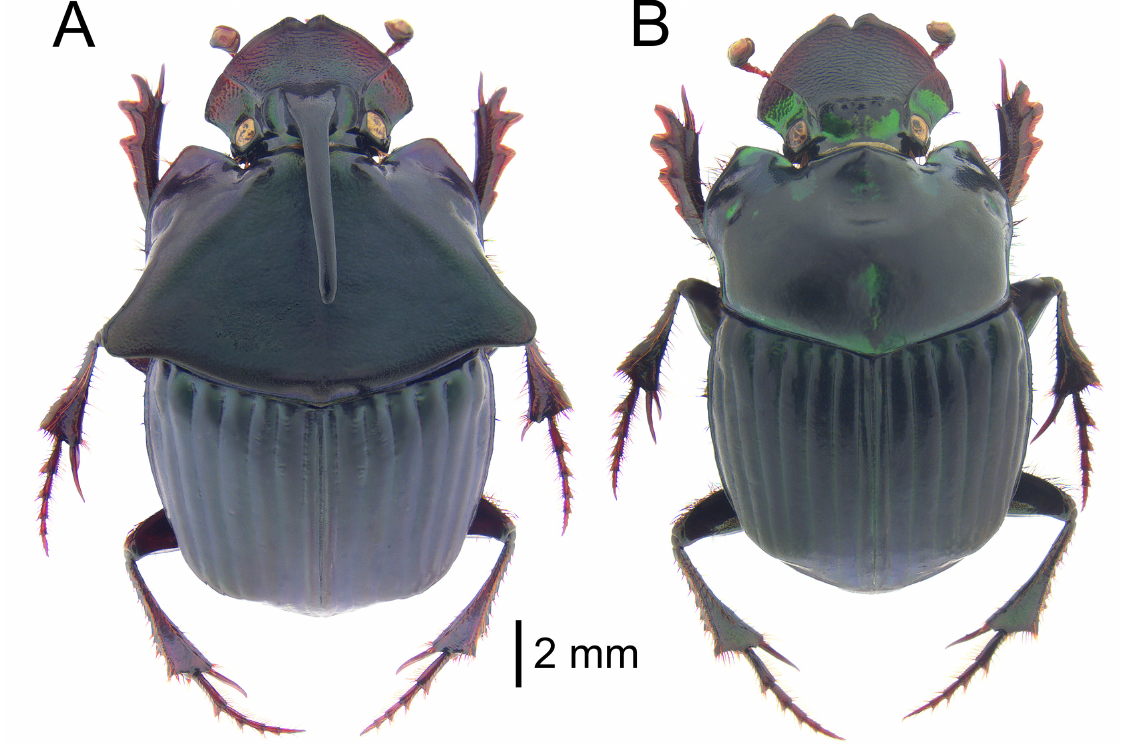
Fig. 13. Phanaeus rzedowskii sp. nov. A . Holotype, ♂ (TAMU). B . ♀